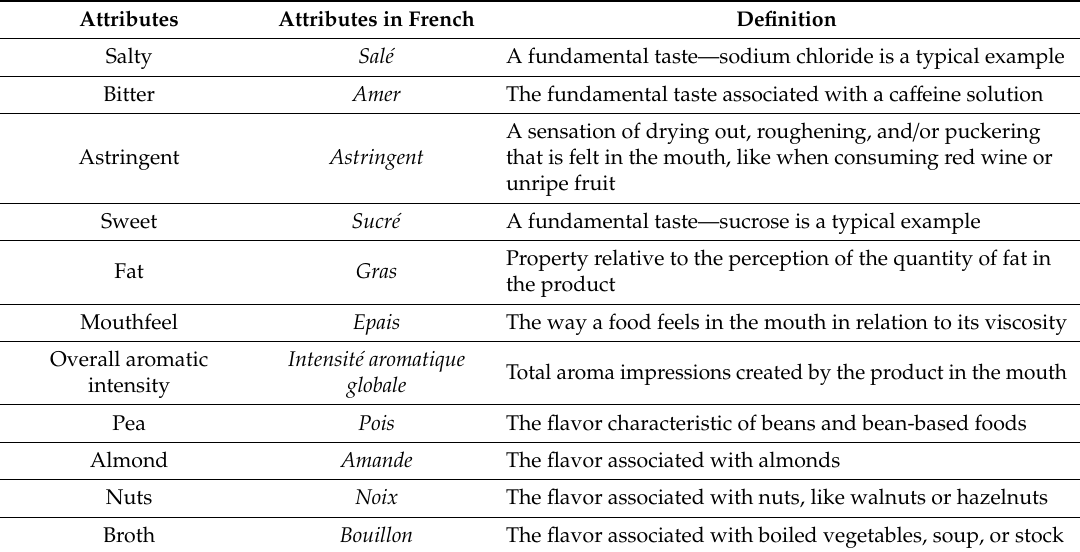
Table 2. Definition of the sensory attributes evaluated by the